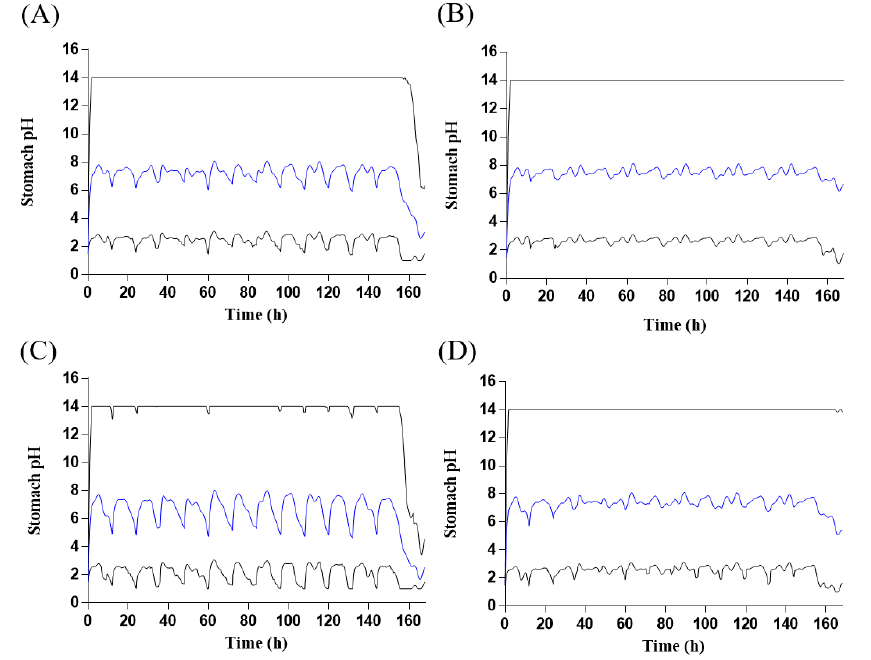
Figure 5. Predicted stomach pH–time profiles of ( A ) administration of 100 mg tegoprazan twice